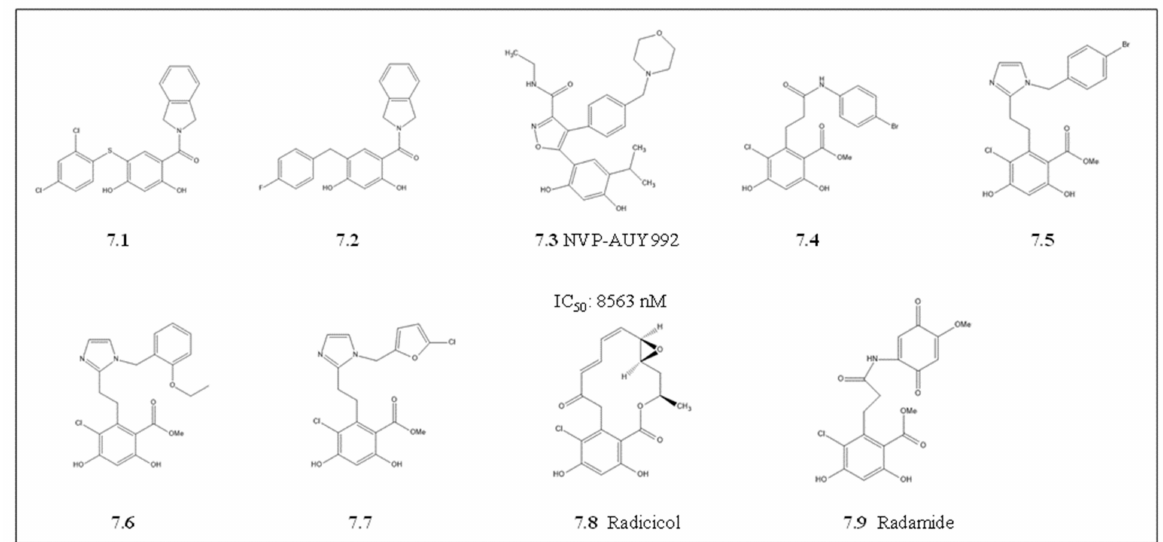
Figure 7. Radicicol and derivatives. The chemical structure of radicicol ( 7.8 ) derivatives include Radamide ( 7.9 ) and synthetic derivatives, compounds 7.1 and 7.2 .NVP-AUY922 ( 7.3 ) is a resorcinylic isoxazole amine compound, with its derivatives 7.4 , 7.5, 7.6 and 7.7 The respective IC 50 value for parasite growth inhibition is